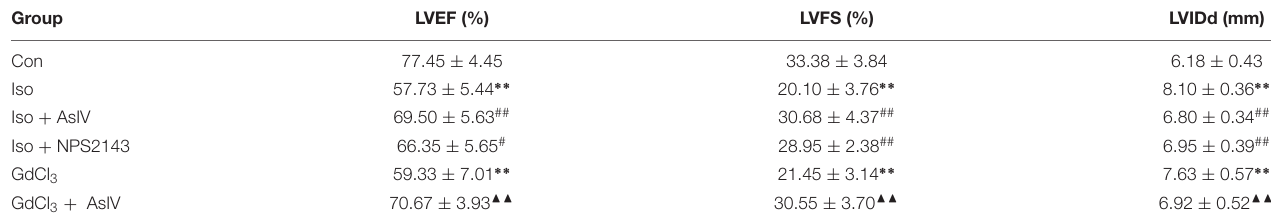
LVEF, left ventricular ejection fraction; LVFS, left ventricular fractional shortening; and LVIDd, left ventricular internal diastolic diameter. n = 4 rats for each group. ∗∗ P < 0.01 vs. the Con group; ## P < 0.01, # P < 0.05 vs. the Iso group; and. (cid:78)(cid:78) P < 0.01 vs. the GdCl 3 group.